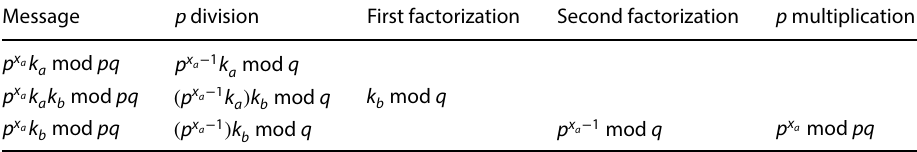
Table 5 The division attack over the exponent-based